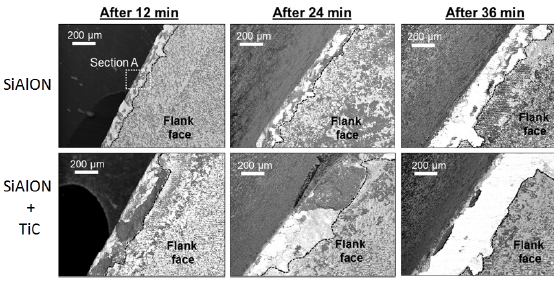
Figure 7: SEM micrographs of the flank faces of the SiAlON and SiAlON+TiC tools after 12, 24 and 36 min side milling tests [4]